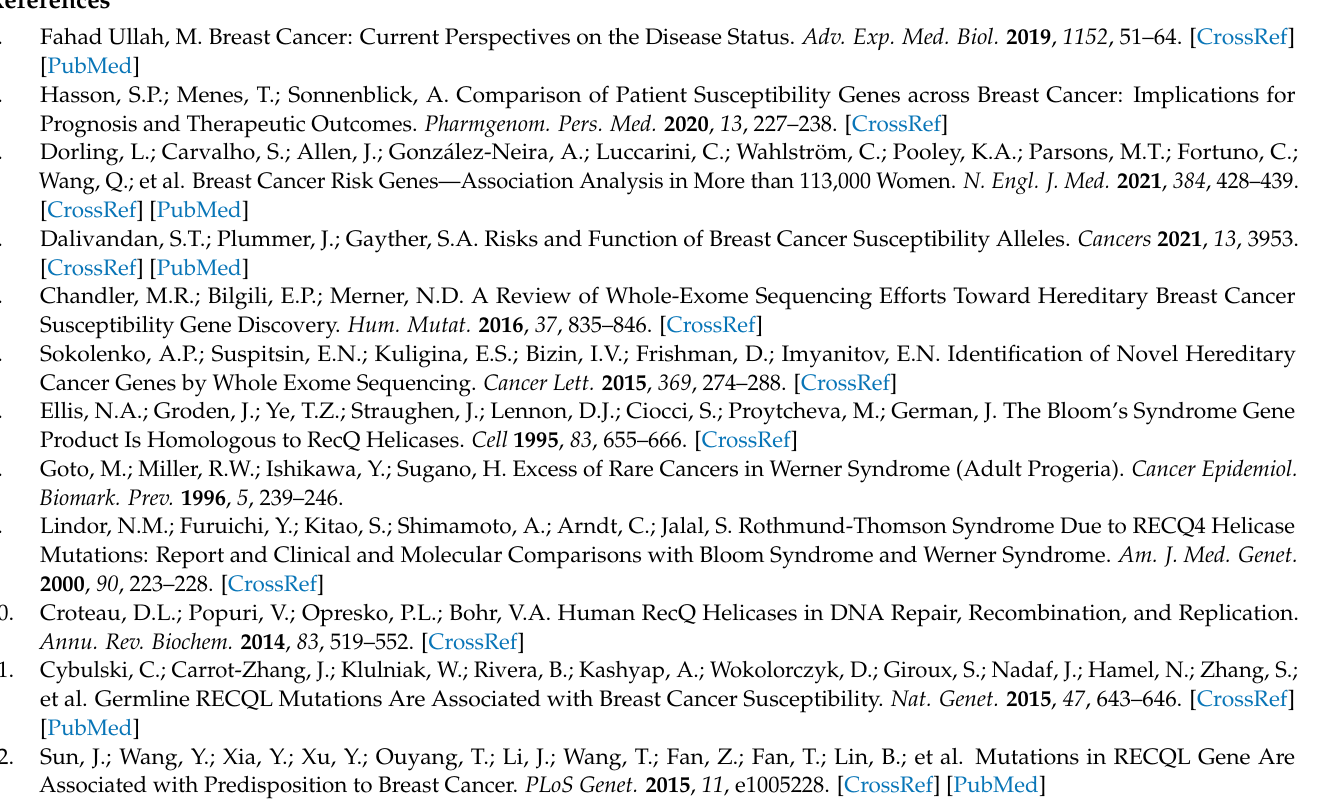
Table S2: Missense and synonymous variants with likely LoF prediction gathered in the 1993